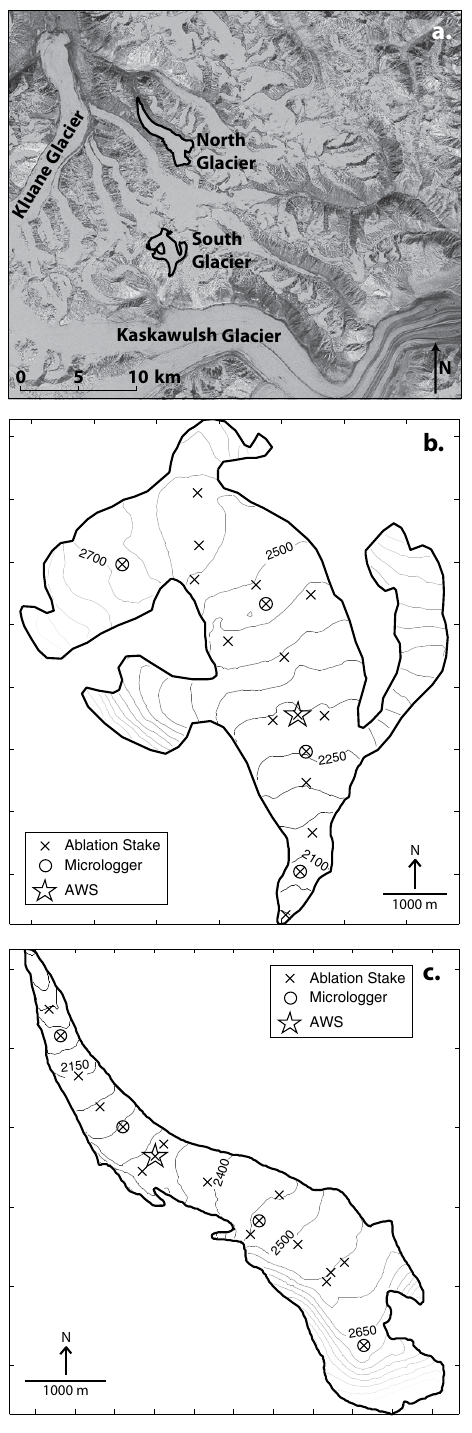
Fig. 1. Study area. (a) Donjek Range between Kluane and Kaskawulsh Glaciers. (b) Surface contour map of South Glacier with locations of ablation stakes, temperature microloggers, and AWS. (c) As for (b) but for North